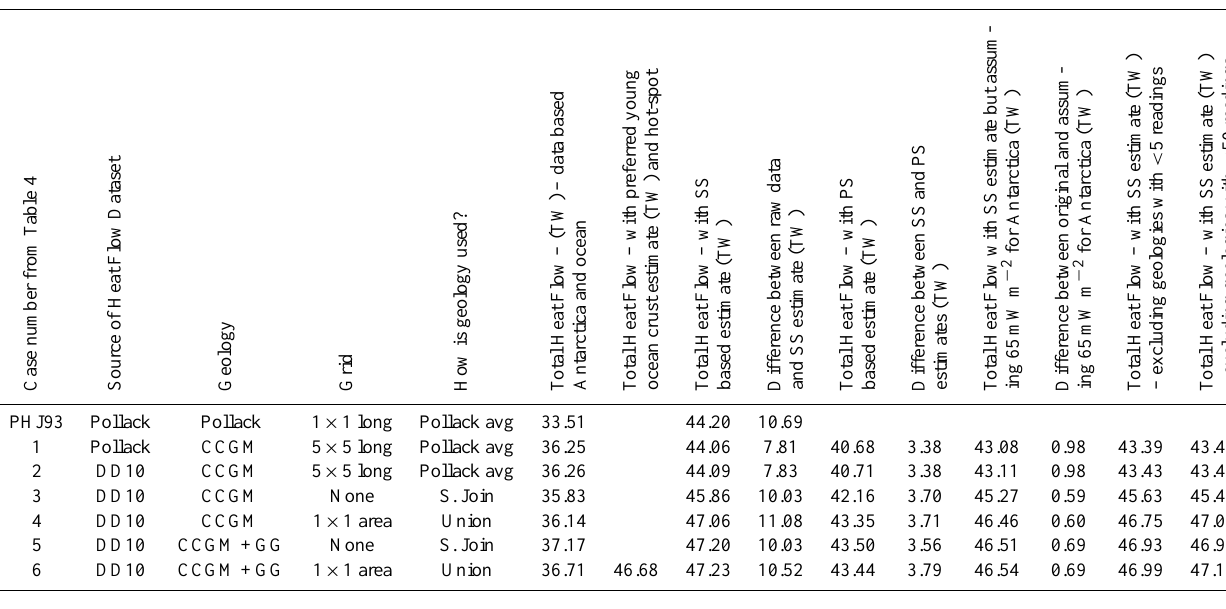
Table 6. The preferred analysis of Earth’s surface heat flux, broken down into five categories: (i) continents from data; (ii) oceanic crust contribution by calculation (age < 66.5Myr); (iii) oceanic crust from data (age ≥ 66.5Myr); (iv) the glacier category; and (v) the hot-spot contribution. Columns of alternatives are also presented. “+1” signifies that this answer uses a 1-degree equal-area grid through a “union”, to reduce the influence of clustering. “50” means that only geology categories with at least 50 heat flow measurements were used in this